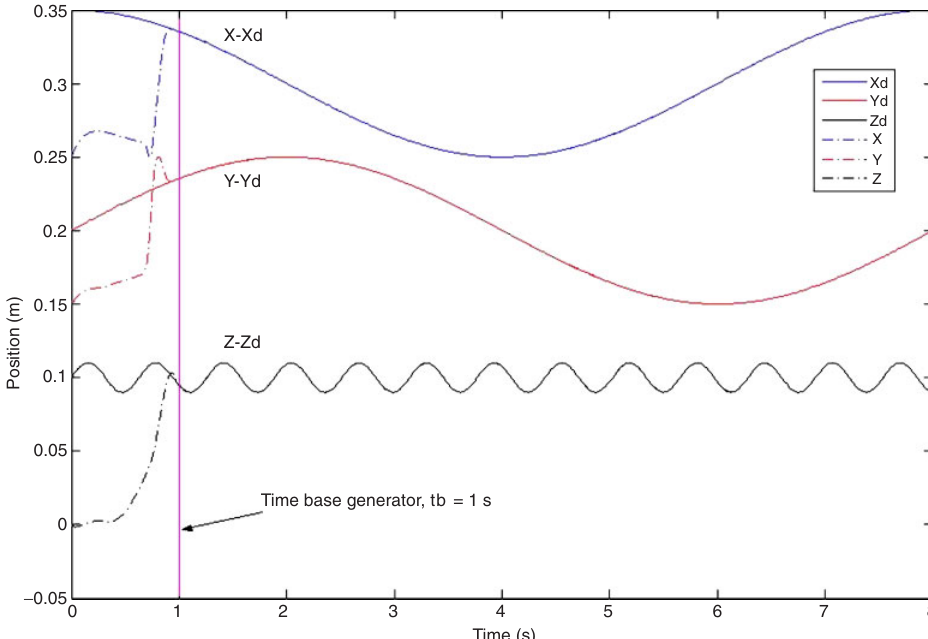
Figure 6 The Cartesian trajectories X , Y and Z , real and desired (tracking in t b = 1 s).